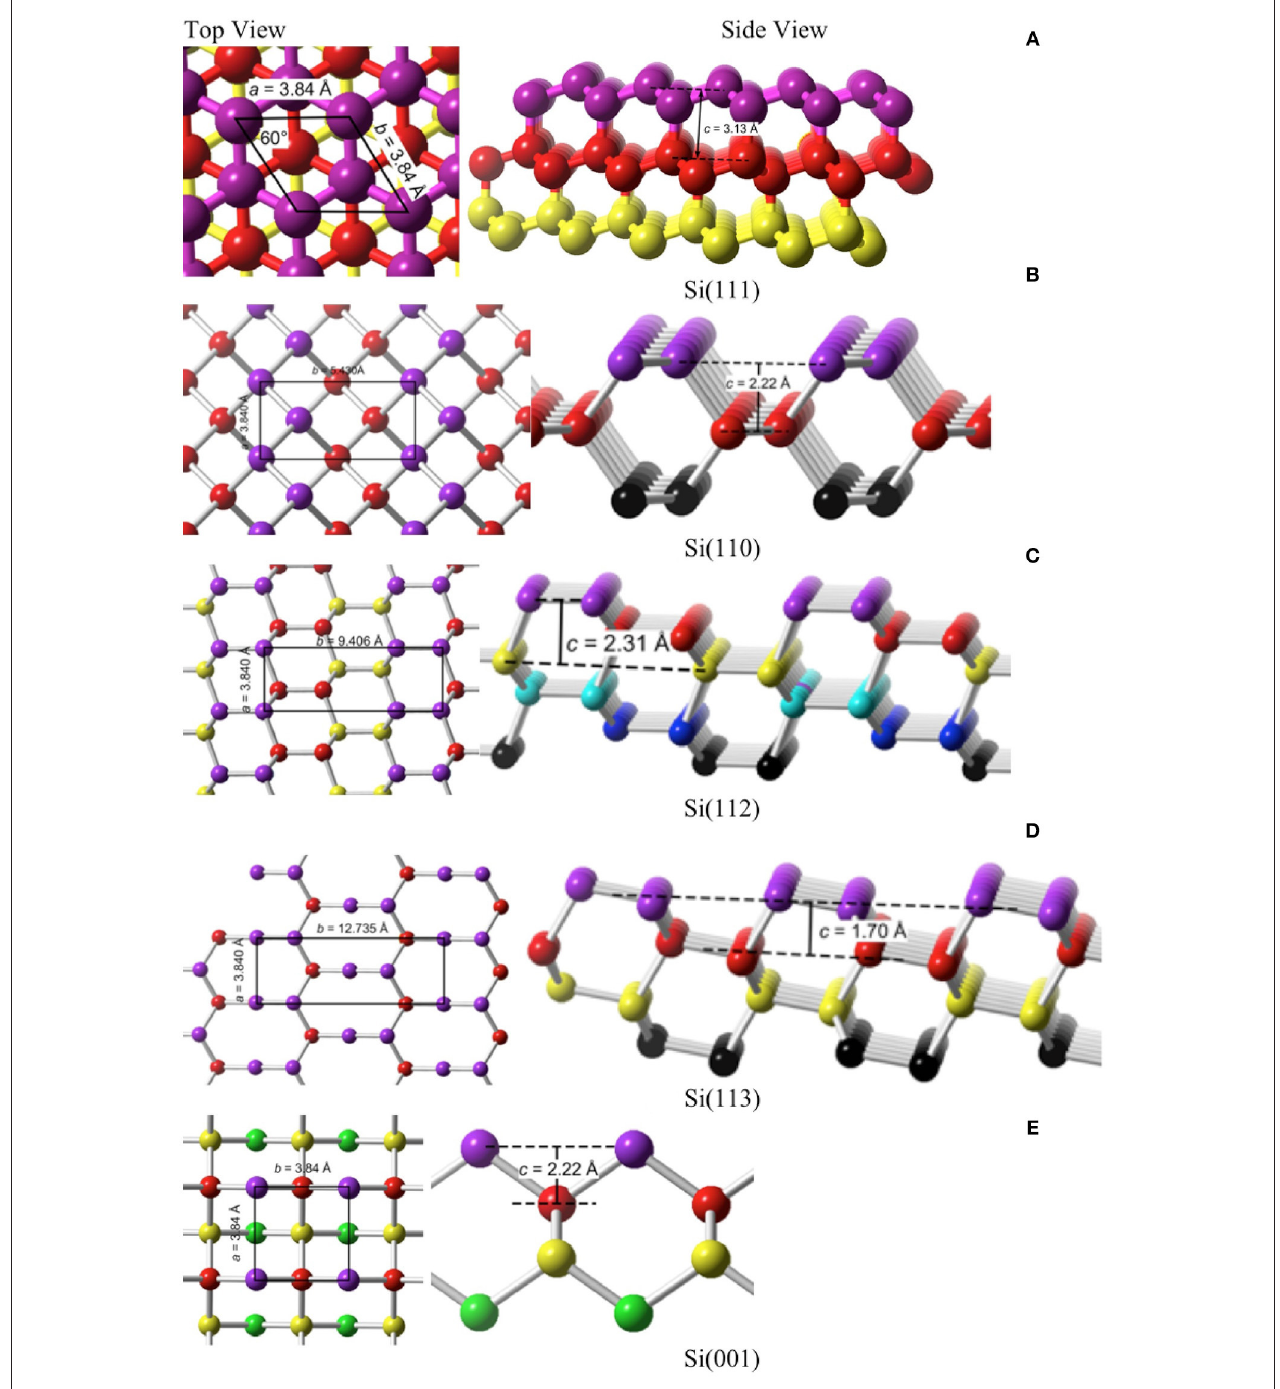
FIGURE 6 | Top and side views of the fives planes that are most likely to be encountered in MACE. (A) Si(111), (B) Si(110), (C) Si(112), (D) Si(113), (E) Si(001).